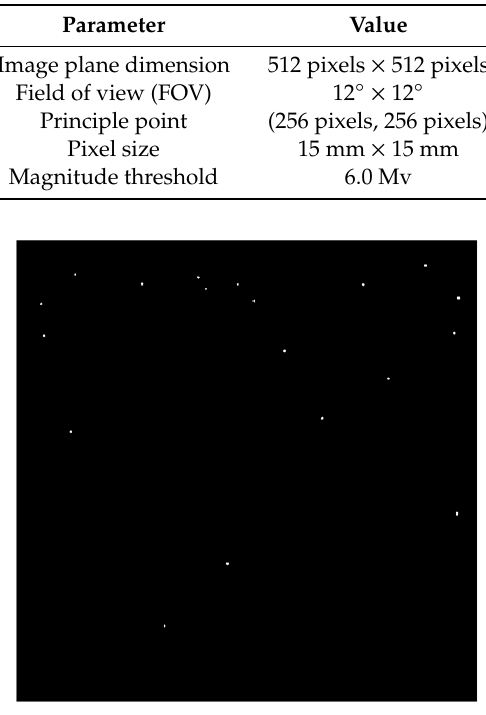
= 0.3). (cid:3017)(cid:3020)(cid:3007)